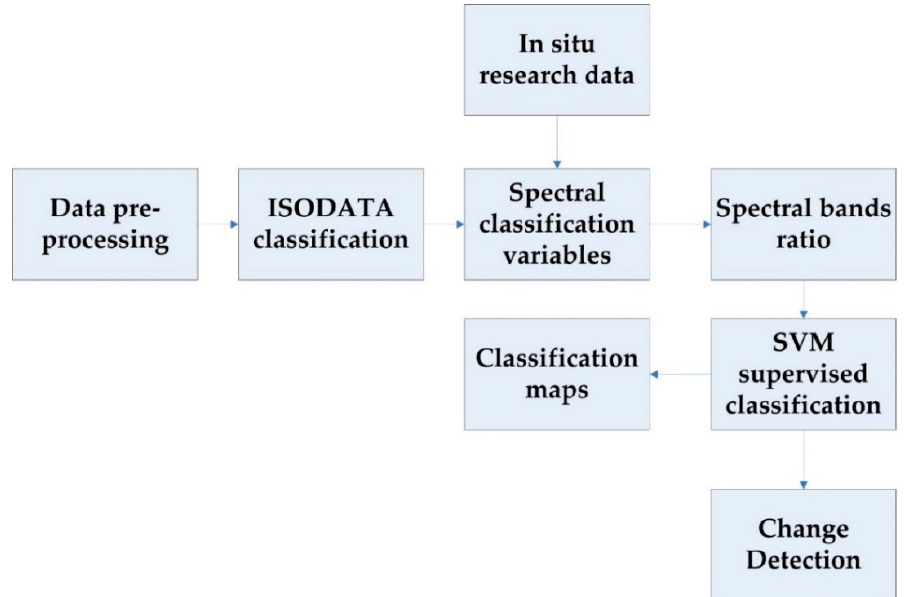
Figure 2. Flowchart of the methodology implemented in this study.